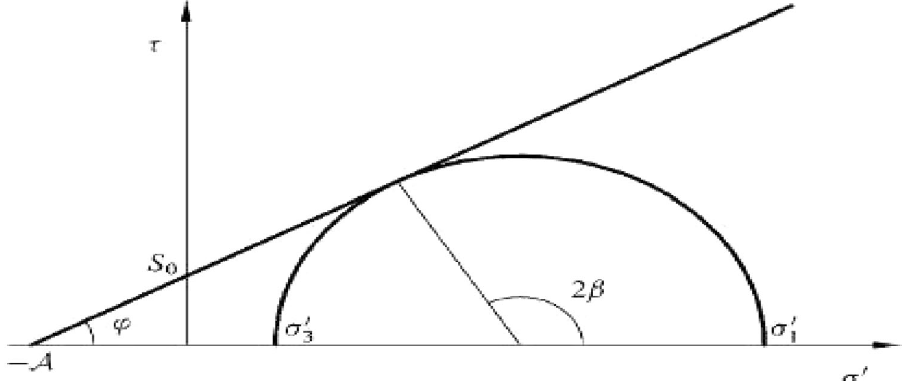
Fig. 2 Mohr–coulomb criterion in s - r 0 space, and Mohr’s circle critical stress